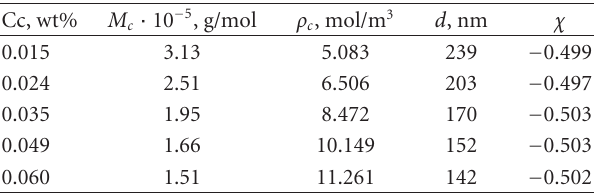
Table 1: E ff ect of changes in Cc on primary structural parameters of PAA